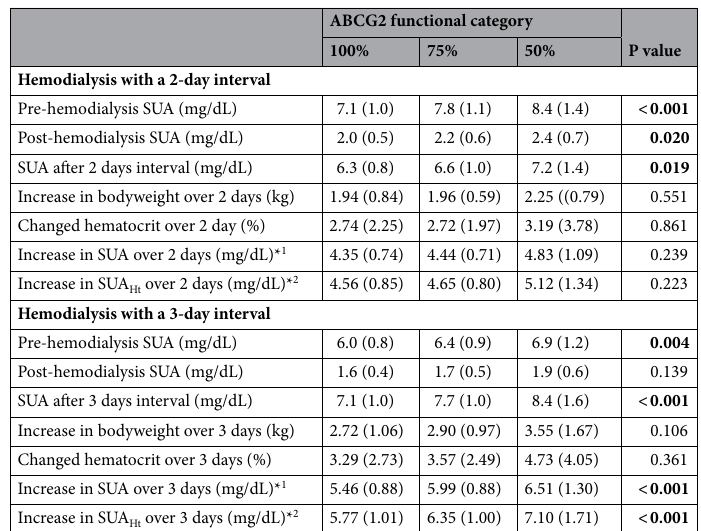
Table 2. Changes in serum urate levels related to hemodialysis. Significant values are in bold. The values represent the mean (standard deviation). SUA* 1 : Unadjusted increase in serum urate levels. SUA Ht * 2 : Increase in serum urate levels adjusted by hematocrit were calculated using the following formula: increase in SUA Ht = unadjusted increase in SUA × [(100−Hematocrit)/(100−Hematocrit post-HD